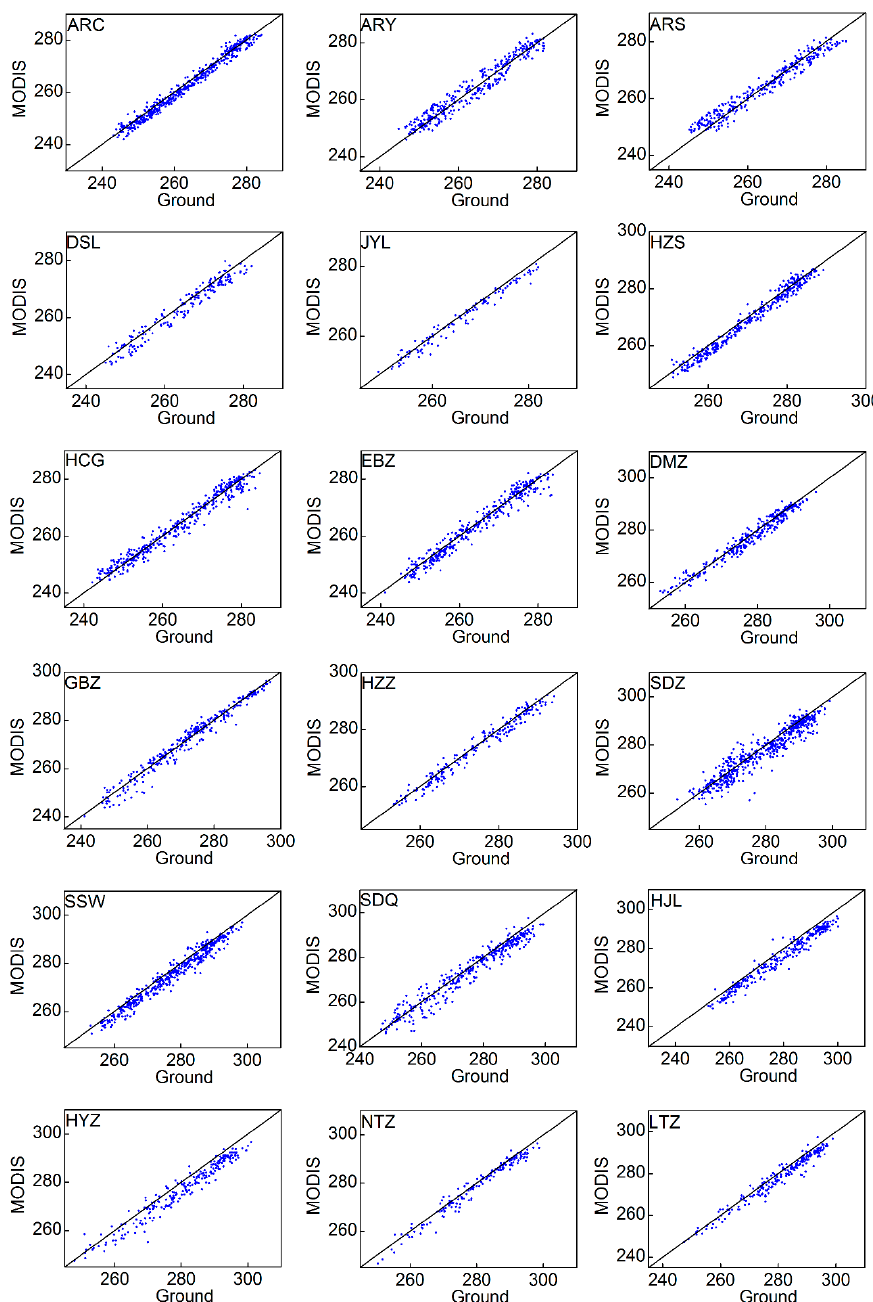
Figure 10. Scatterplots of the nighttime comparison results of the LSTs from MODIS and the LST measurements at the eighteen HiWATER sites. measurements at the eighteen HiWATER